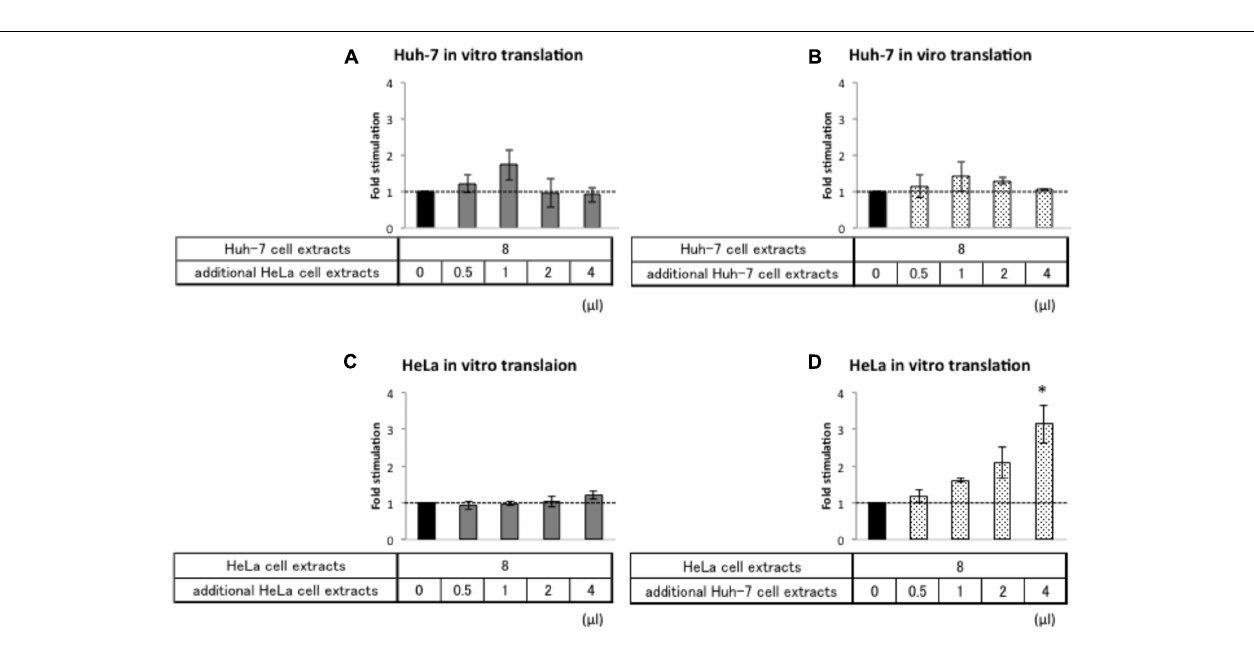
Frontiers in Genetics |